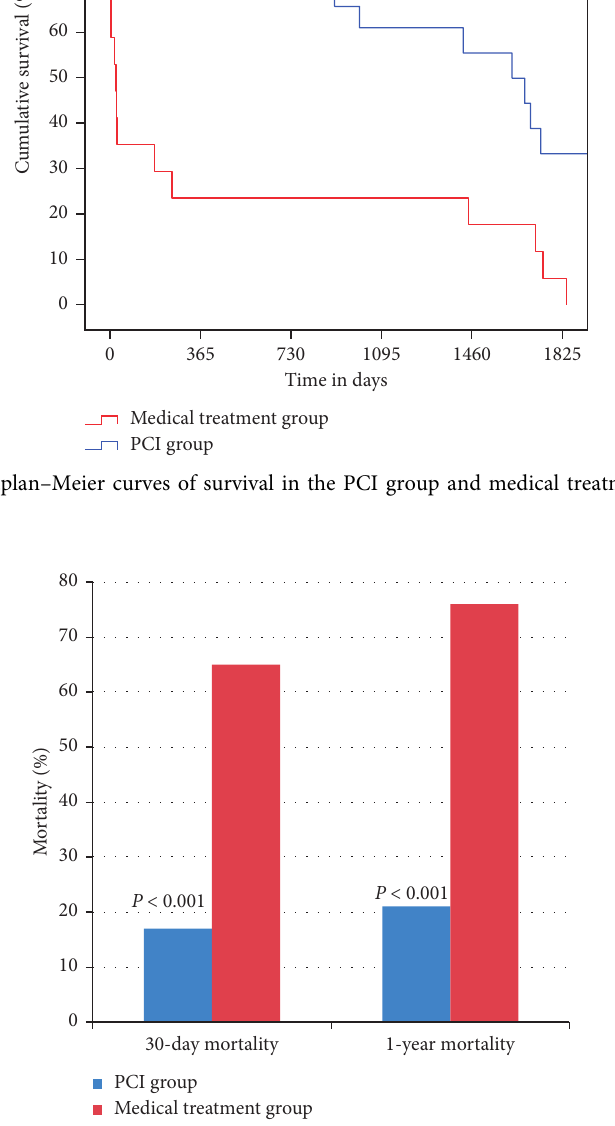
Figure 2: Thirty-day and one-year mortality rates of the PCI group and medical treatment